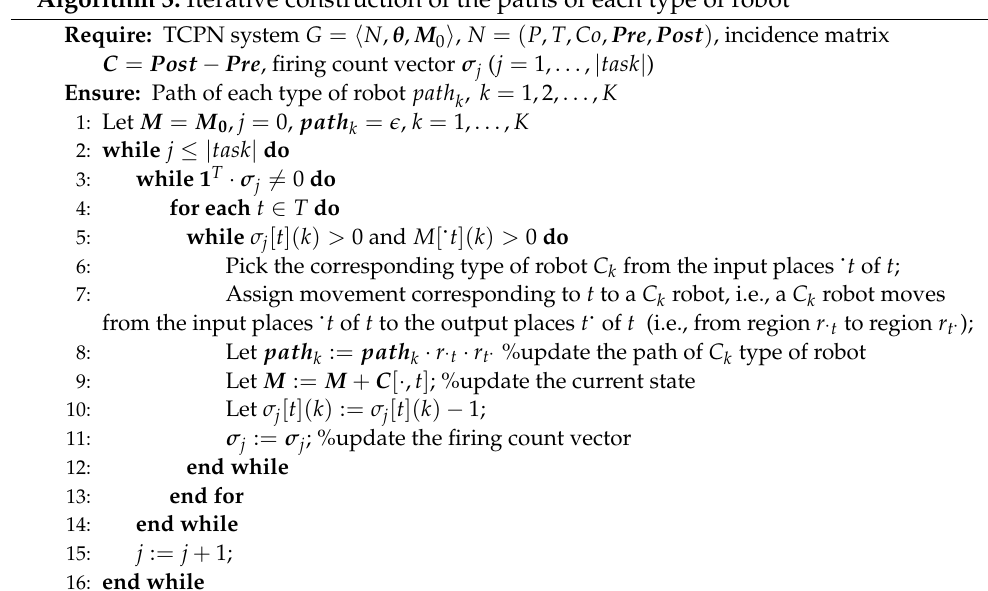
Algorithm 3: Iterative construction of the paths of each type of robot